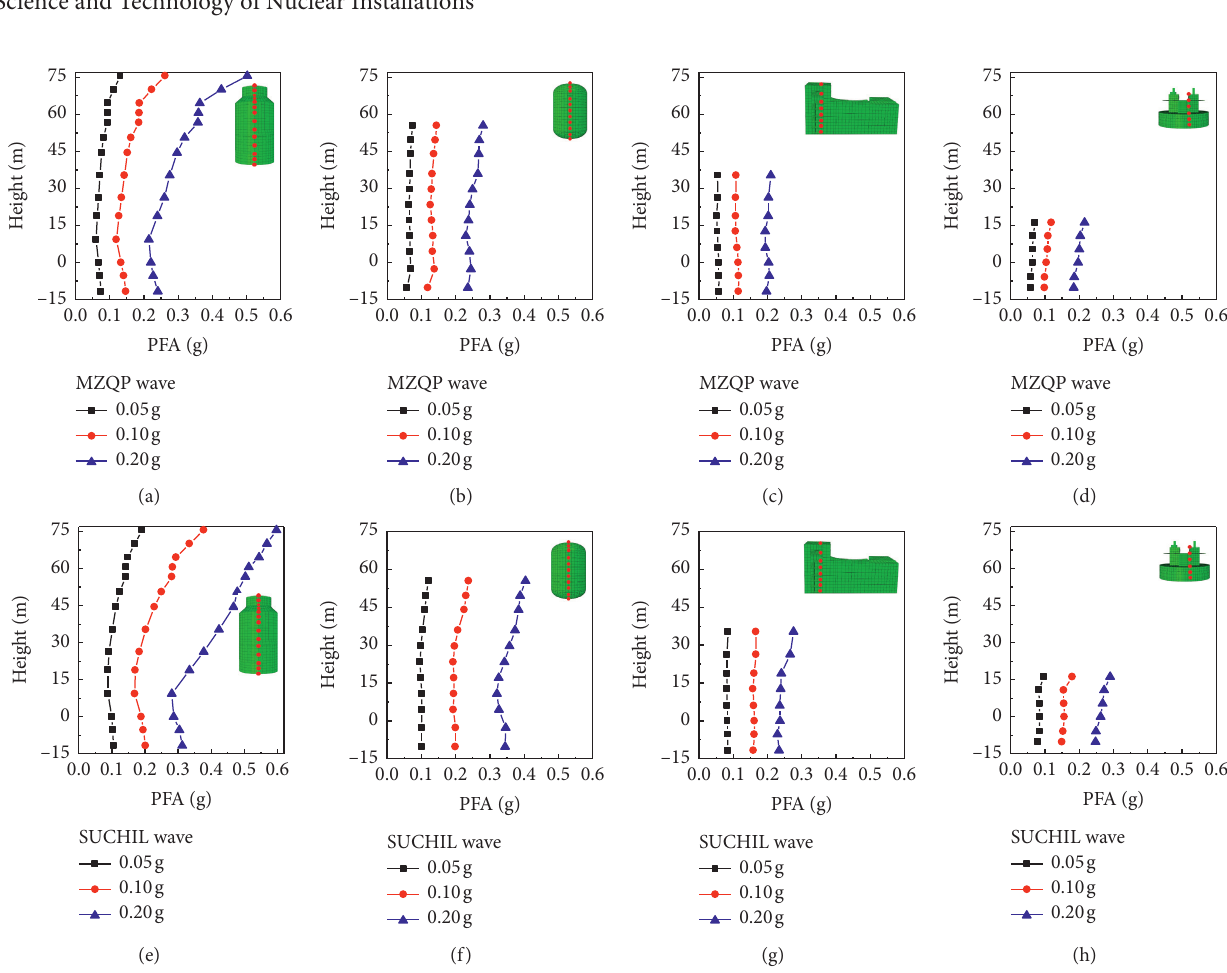
Figure 9: Relationship between the PFA and the height of the nuclear island